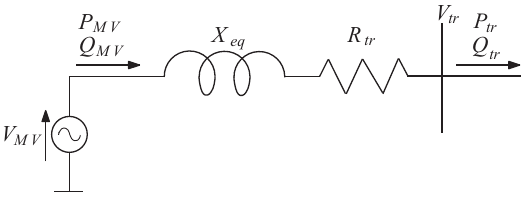
Figure 2. Electric equivalent circuit of the Medium/Low Voltage substation.